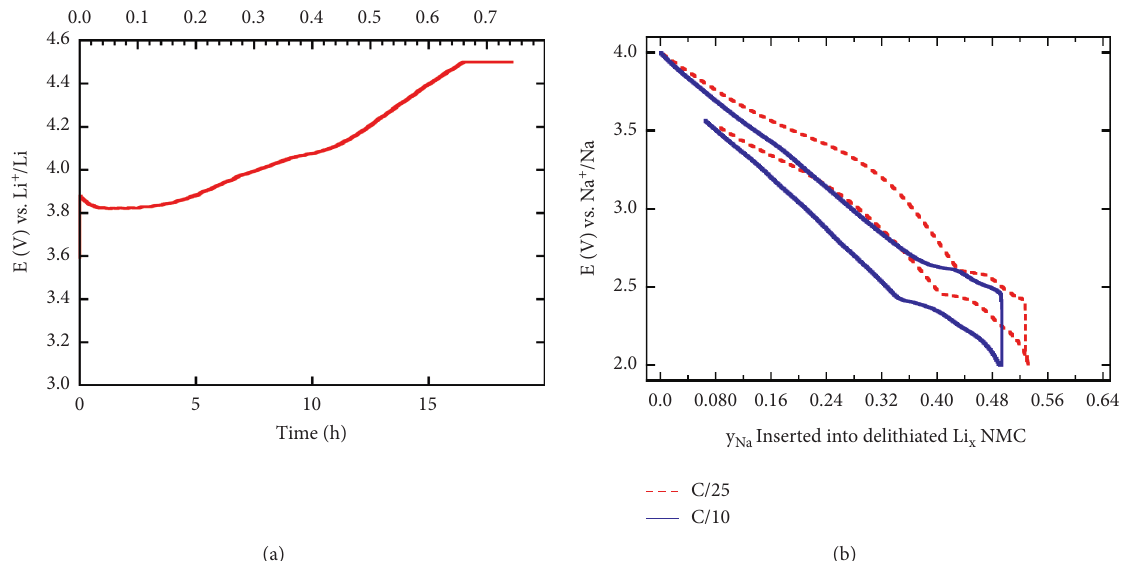
Figure 2: (a) Initial charge curve (oxidation state) of LiNMC in half-cell Li | LiPF charge-discharge curve of Na z NMC in half-cell Na | NaClO 4 /PC-FEC (98:2) | Na z NMC.